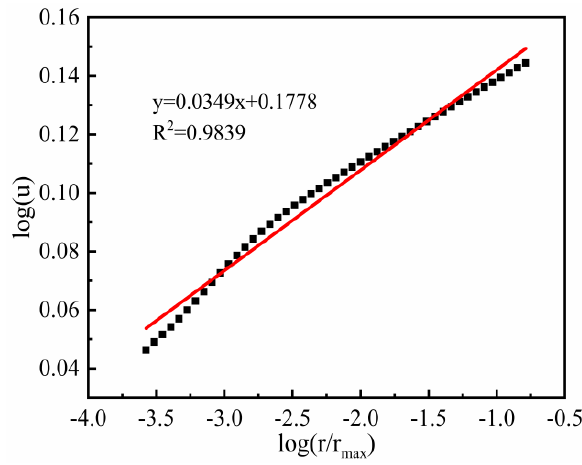
Figure 14. Plot of log (u) versus log (r/r max ) of pore sizes larger than 0.05 μ m of mortar (Black square: NMR test data).